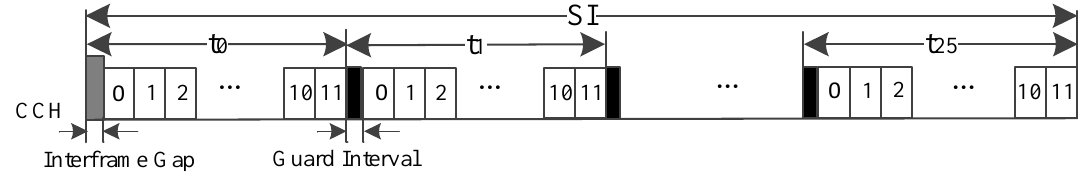
Table 315: pmboxdraw Box-Drawing Symbols Figure 19. Operation of ETCM protocol. Figure 19. Operation of ETCM protocol.